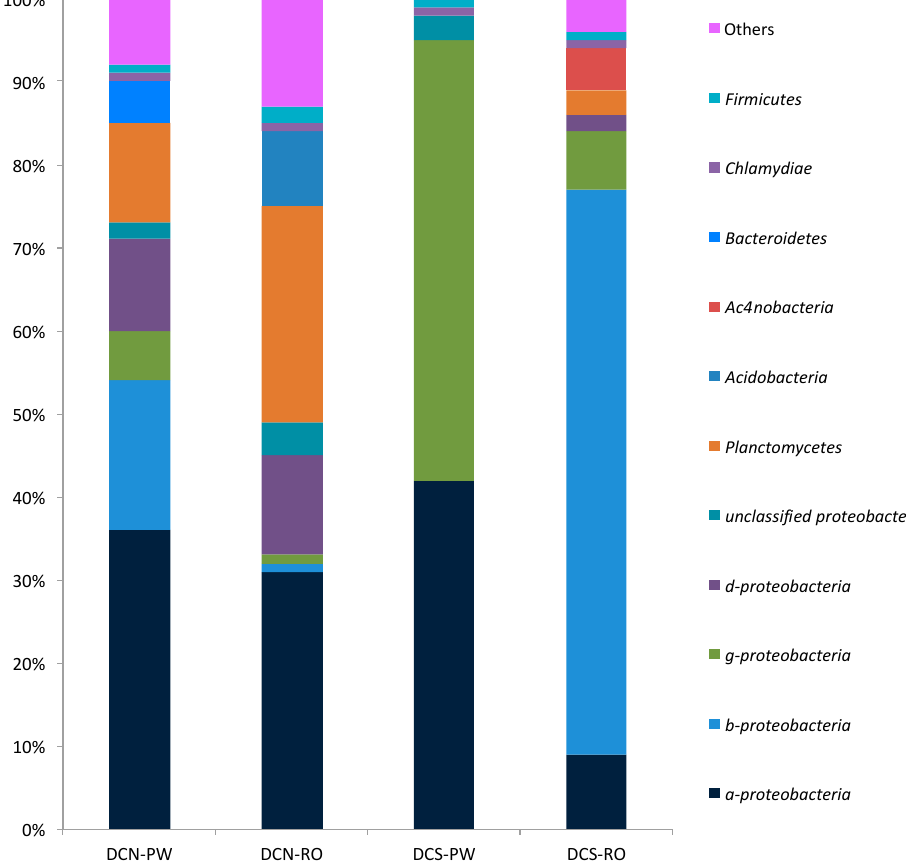
Figure 5. Relative abundance (percentage) of sequences of bacterial phylogenetic groups and Proteobacteria subclasses present in potable water (PW) and reverse osmosis (RO) membranes of the north central area dialysis centre (DCN) and south-central area dialysis centre (DCS). Table 1. Identification of heterotrophic bacterial strains isolated from both haemodialysis centres.